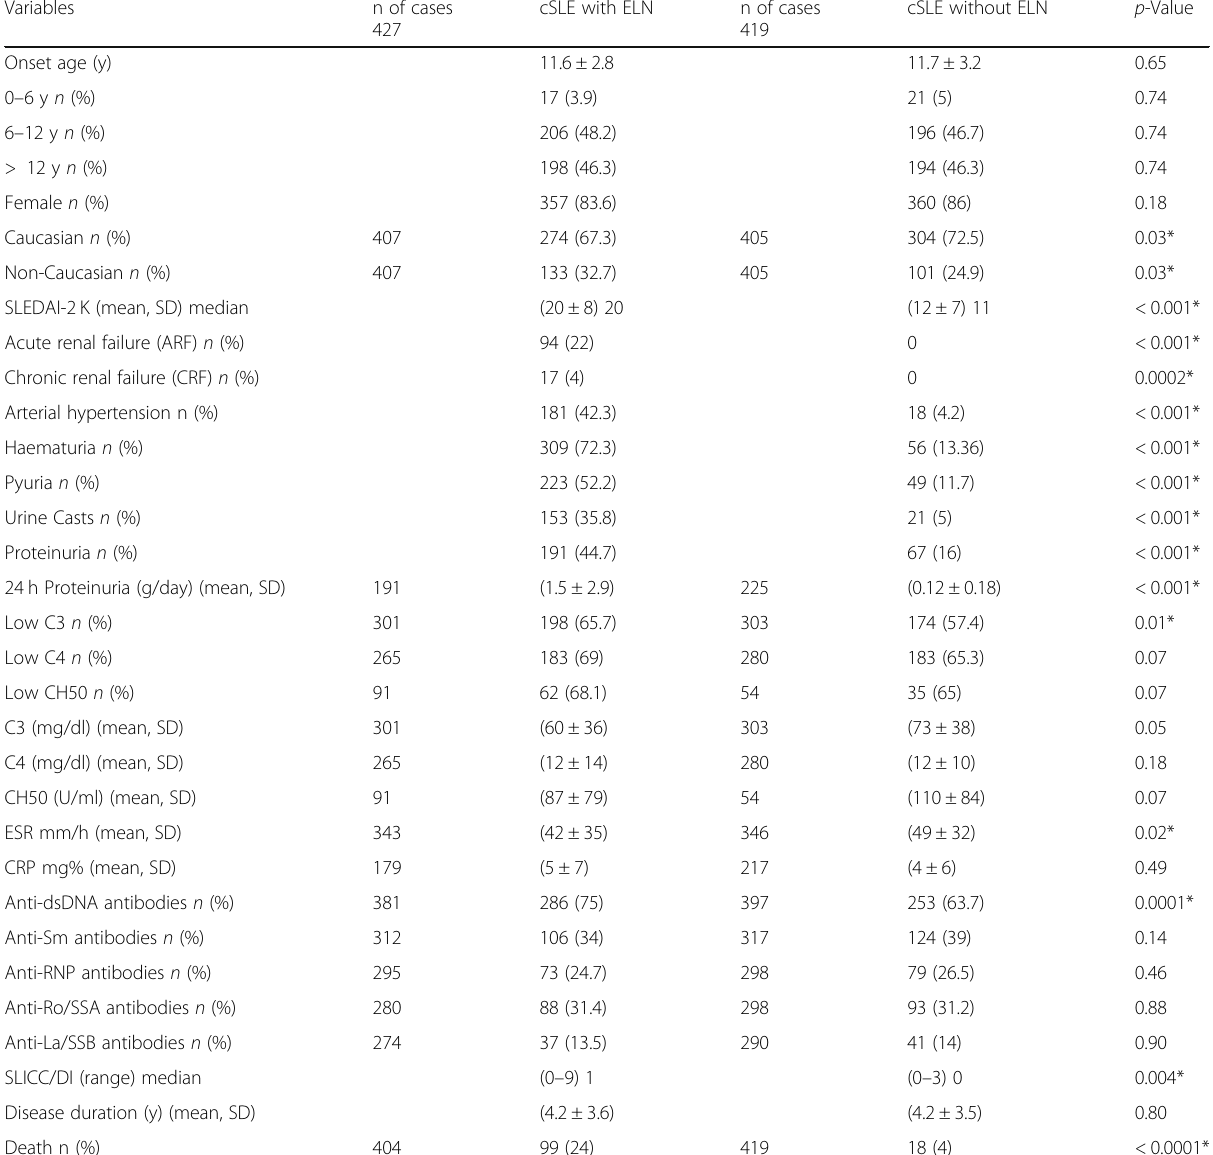
Table 1 – Demographic and clinical features, laboratory parameters, disease activity, damage scores and death rates comparison in childhood-onset Systemic Lupus Erythematosus (c-SLE) patients with and without early onset lupus nephritis